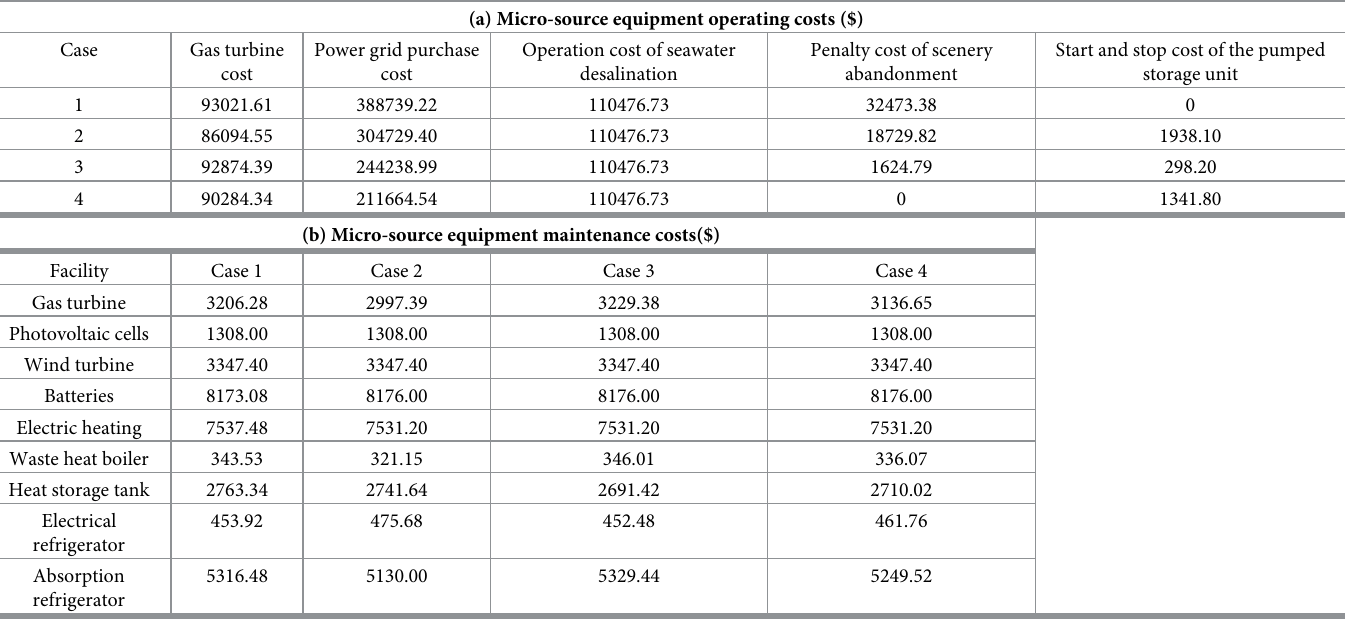
Table 3. Micro-source equipment operating/maintenance costs